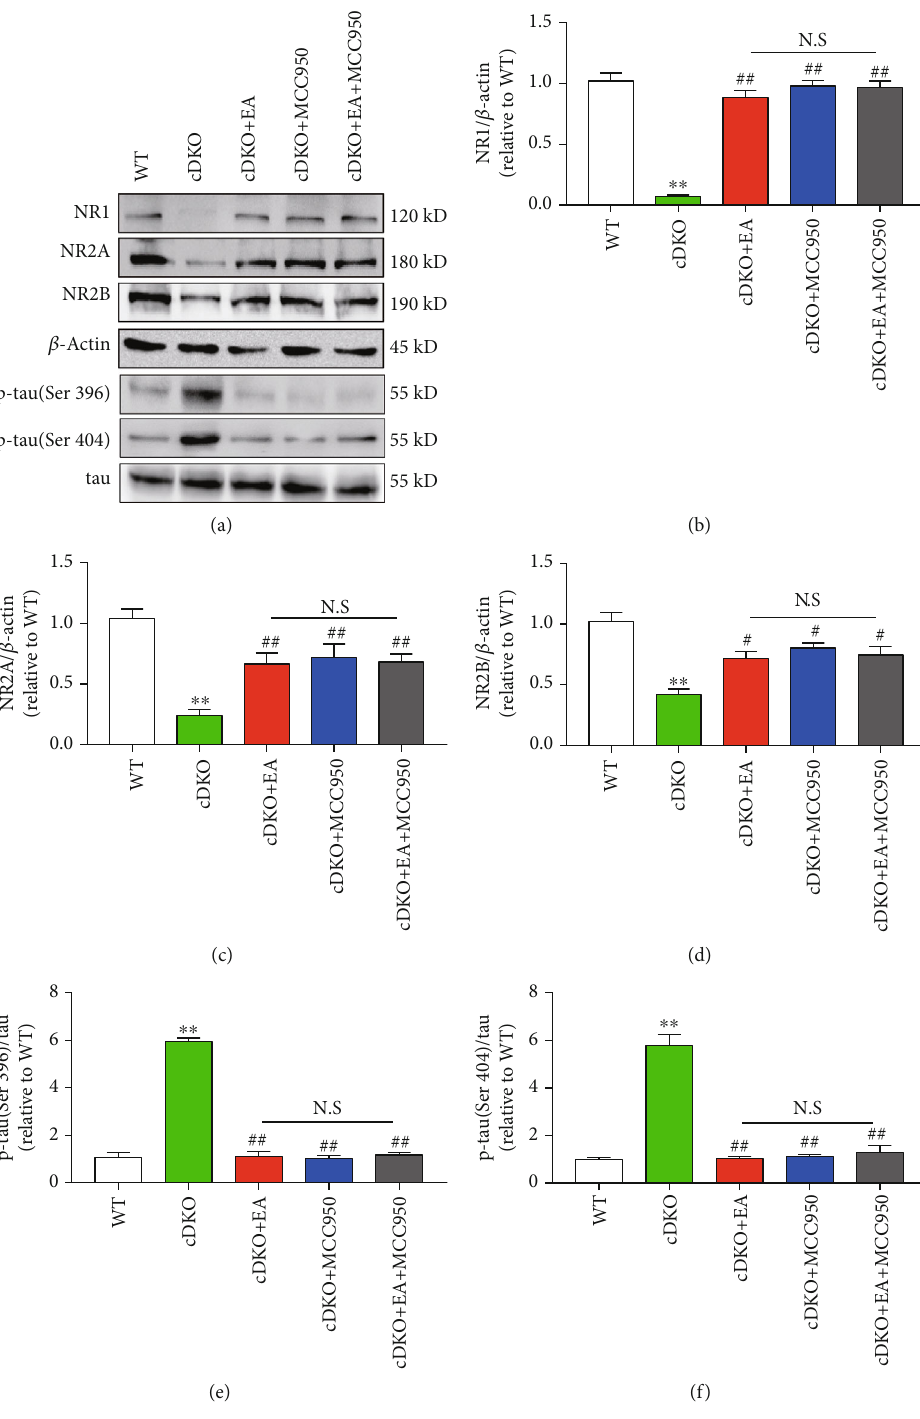
Figure 6: MCC950 does not further increase the e ff ect of EA on ameliorated hyperphosphorylated tau and impaired NMDA receptors in the hippocampus of PS cDKO mice. (a) Representative Western blot of NR1, NR2A, NR2B, p-tau (Ser396), and p-tau (Se404) in the hippocampus. (b) – (f) Quanti fi cation of NR1, NR2A, NR2B, p-tau (Ser396), and p-tau (Ser404) in the hippocampus according to the respective levels of β -actin or total tau ( n = 6 mice for each group). The values were expressed as relative changes to the respective WT mice, which was set to 1. Data are the mean ± S : E : M : , ∗ p < 0 : 05 , ∗∗ p < 0 : 01 vs WT mice. # p < 0 : 05 , ## p < 0 : 01 vs cDKO